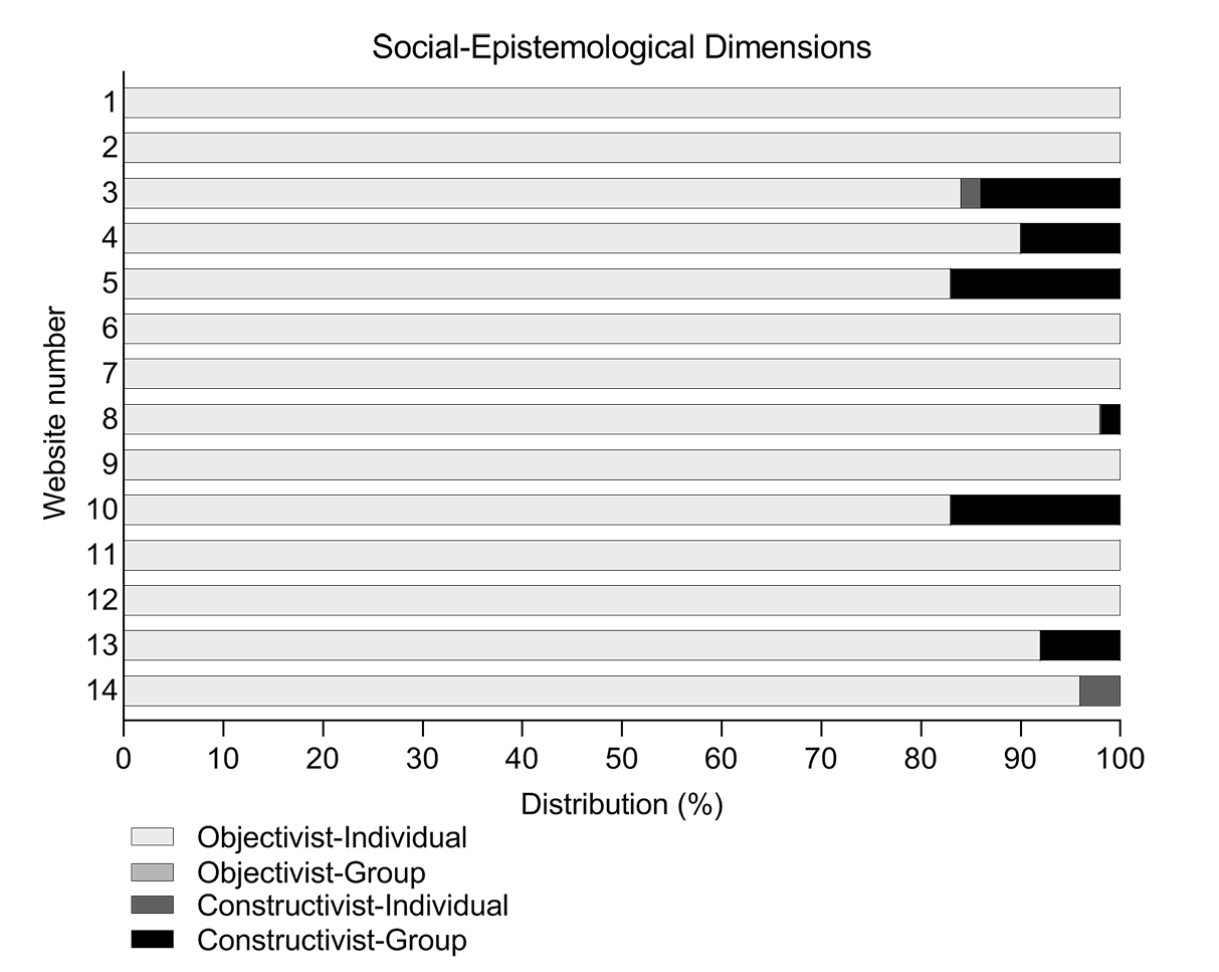
Figure 4. Distribution of social-epistemological dimensions per